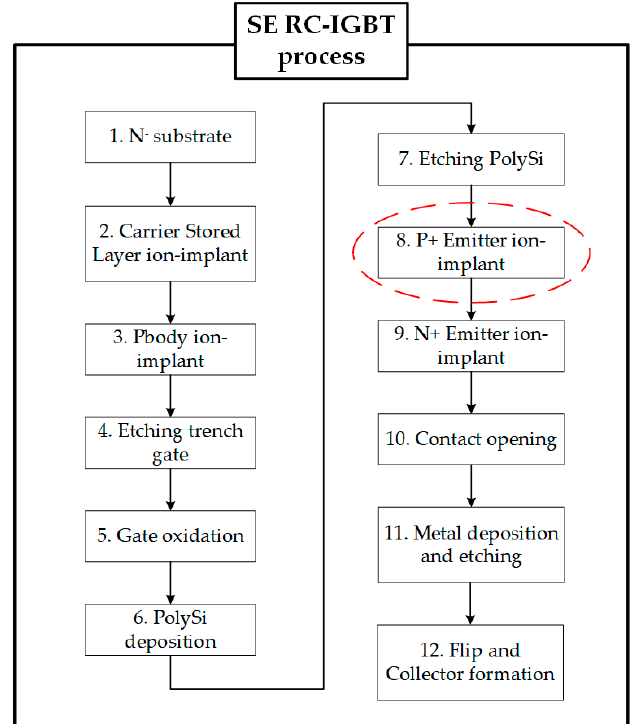
Figure 14. Process flow for SE RC-IGBT.